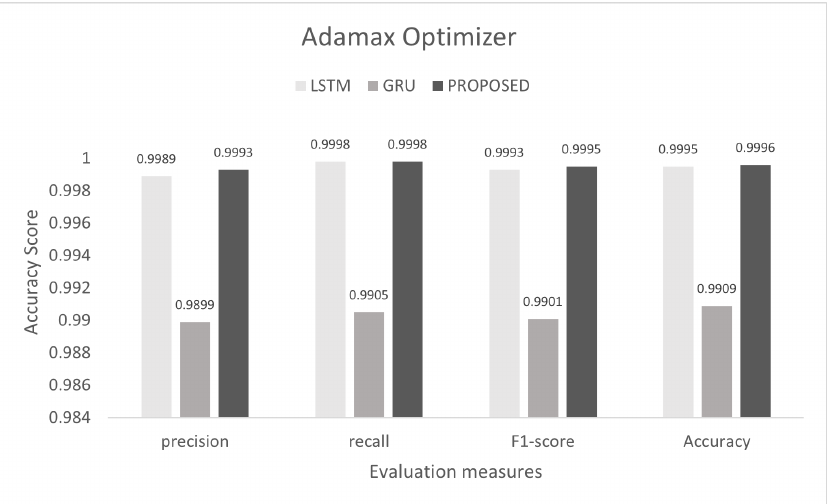
Figure 16. Evaluation on Adamax with the car-hacking